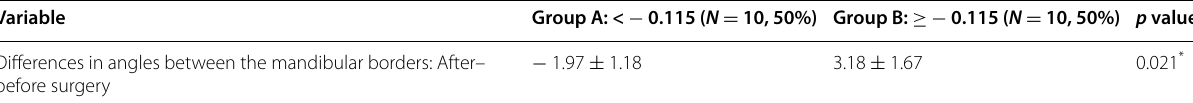
Table 5 A comparison of the differences in angles between the mandibular edges of both groups Variable Differences in angles between the mandibular borders: After– before The table shows a comparison of the differences in angles between the mandibular borders of both groups according to the differences of surgical outcomes at the mandibular upper borders